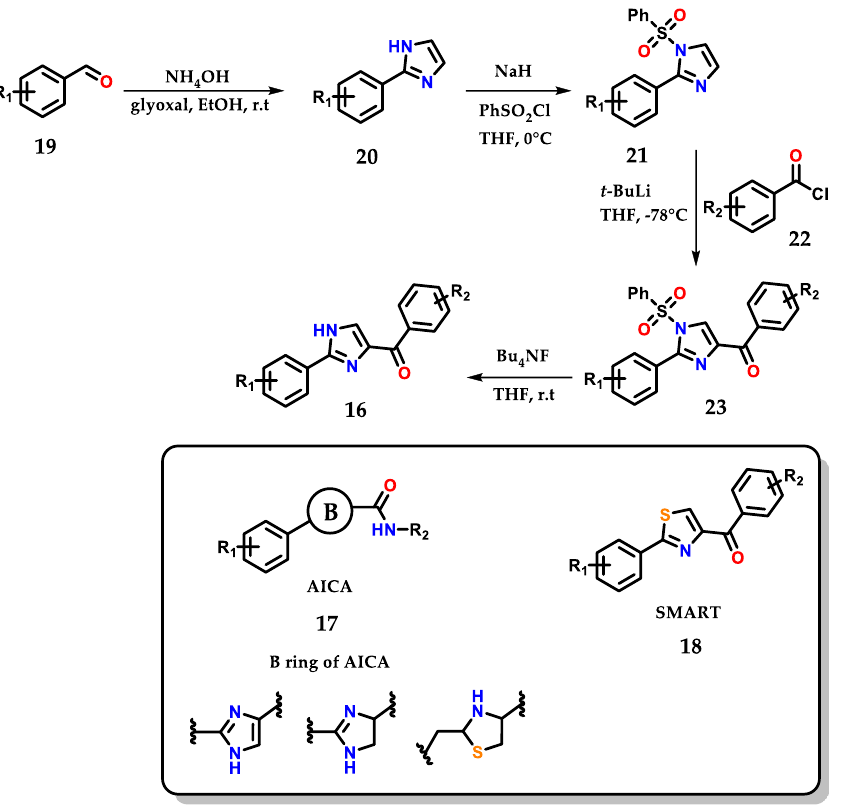
Figure 12. Obtaining 2-aryl-4-benzoyl-imidazoles 16 based on AICA 17 and SMART 18 .